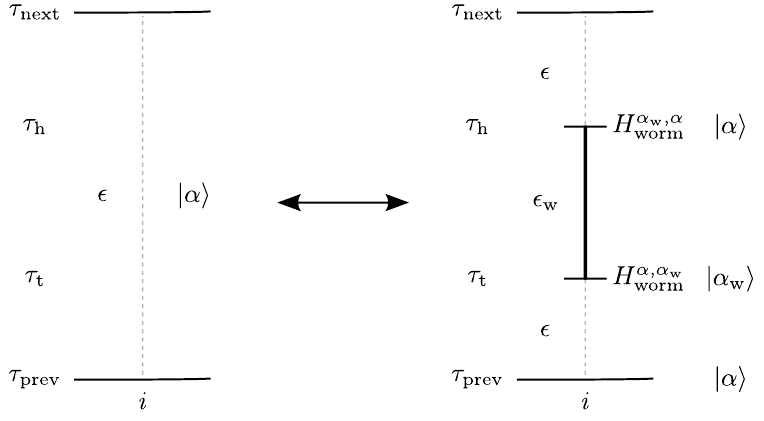
Figure 15: Insert / Delete worm. A worm is inserted by first randomly sampling imaginary times τ , τ inside an also randomly sampled flat interval, delimited by t h the times τ and τ . A worm head and tail are then inserted at τ prev next respectively. ε and ε correspond to the eigenvalues of the diagonal part of the w 〉 , respectively. The case of τ Hamiltonian for Fock states | α 〉 and | α w valid and would correspond to an antiworm insertion, in which case a particle is first deleted by the worm head, then one created by the